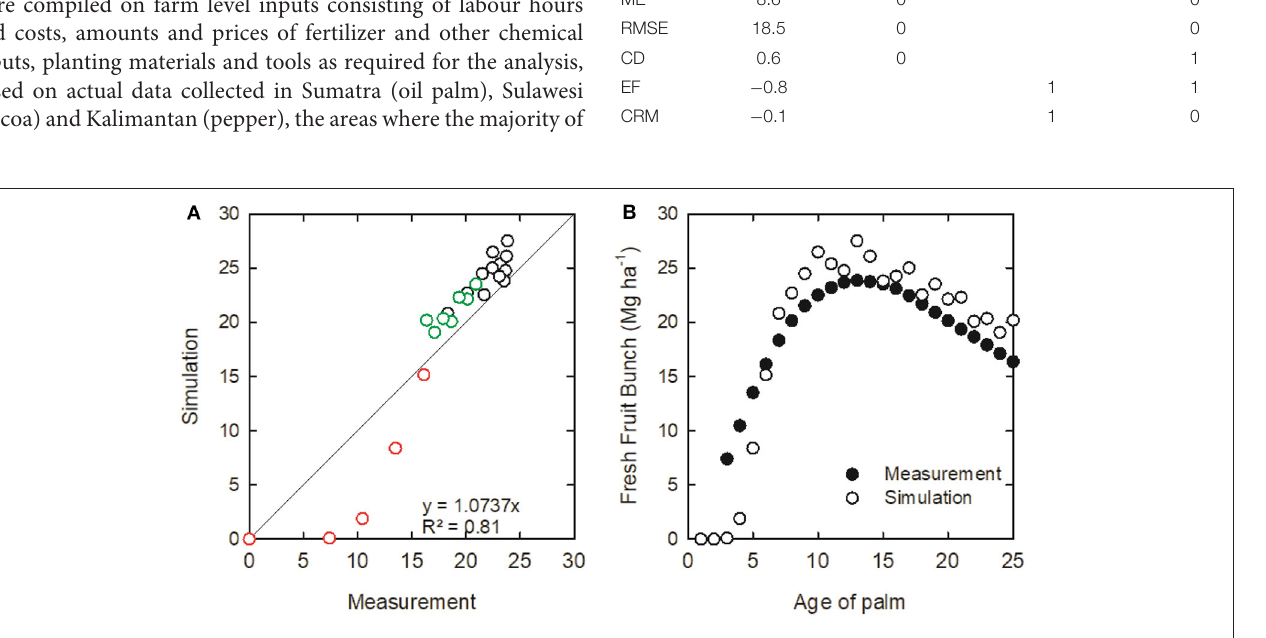
Frontiers in Sustainable Food Systems |